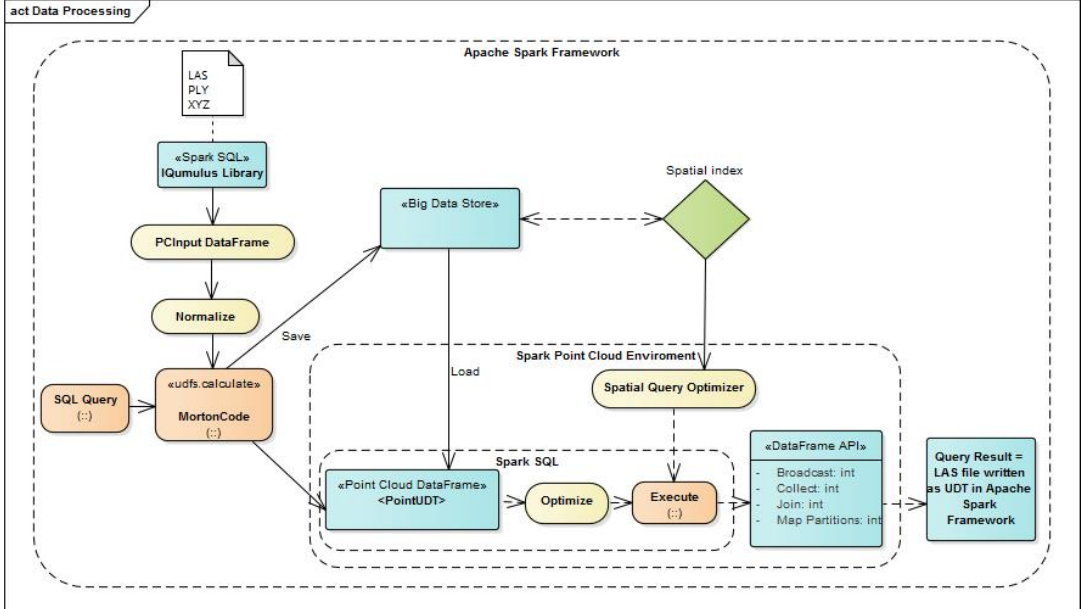
Figure 1. Data ‐ processing module. Figure 1. Data-processing